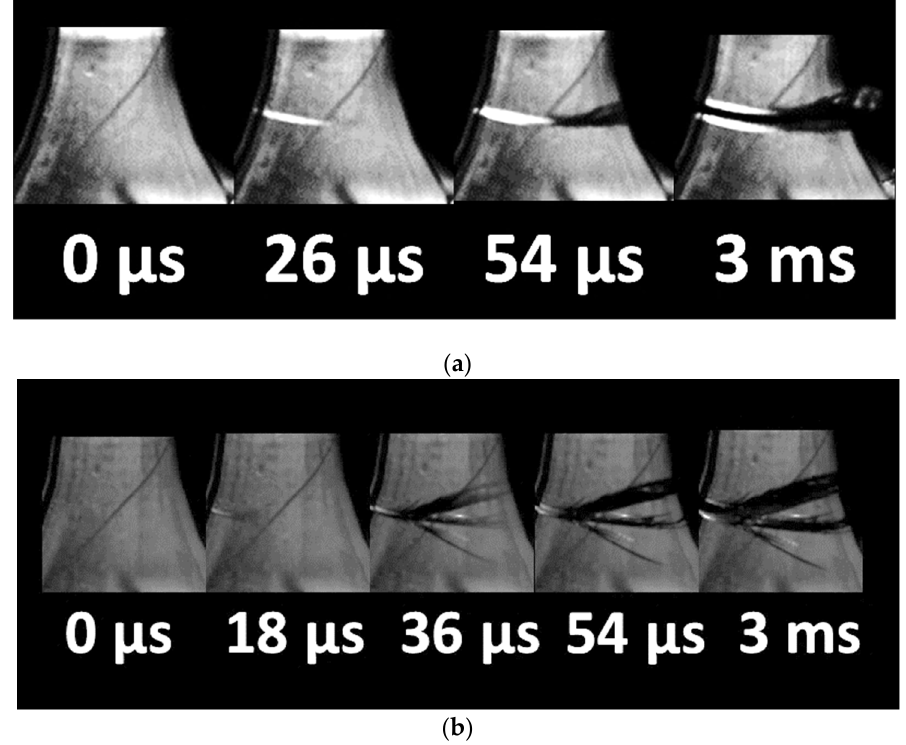
Figure 8. Crack propagation in printed composites ( a ) LG non-cured state, ( b ) LC cured state.